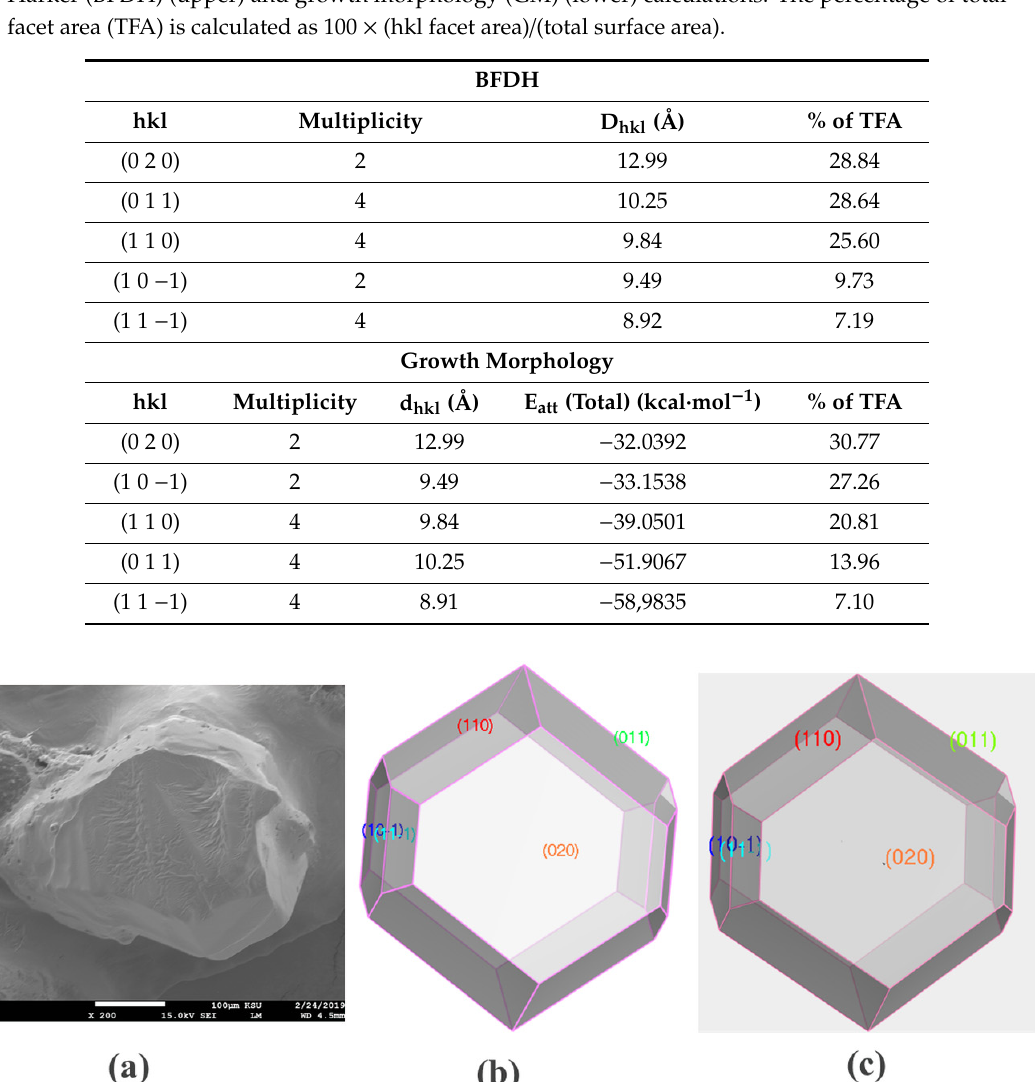
Figure 8. Crystal morphology comparison between the SEM images ( a ); BFDH model ( b ); GM model ( c ). The morphologically important (MI) facets are presented by their Miller indices.